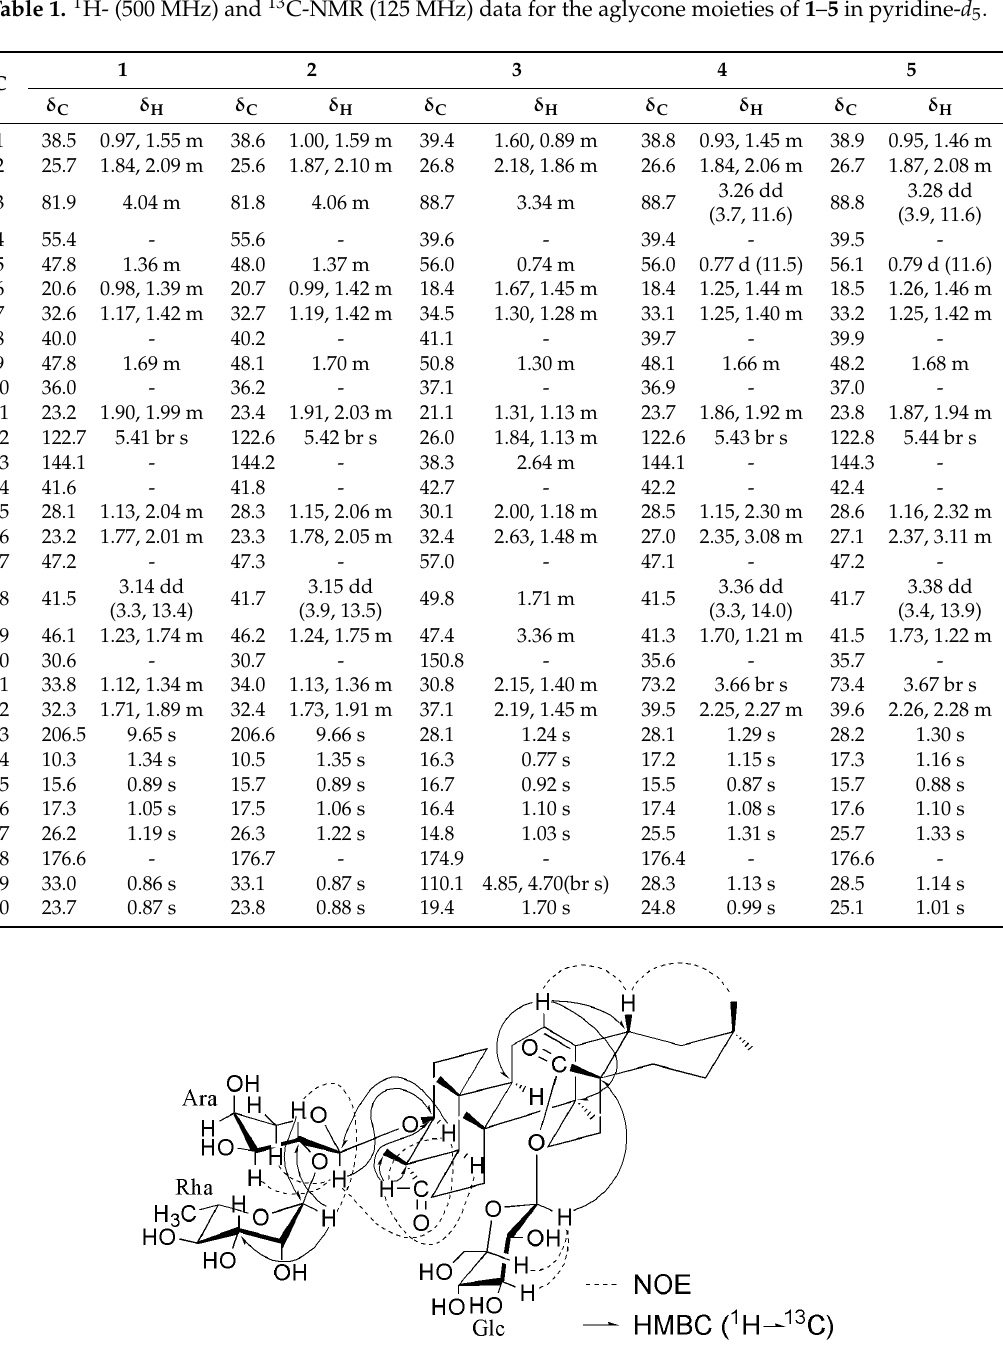
Table 1. 1 H- (500 MHz) and 13 C-NMR (125 MHz) data for the aglycone moieties of 1 – 5 in pyridine- d 5 .